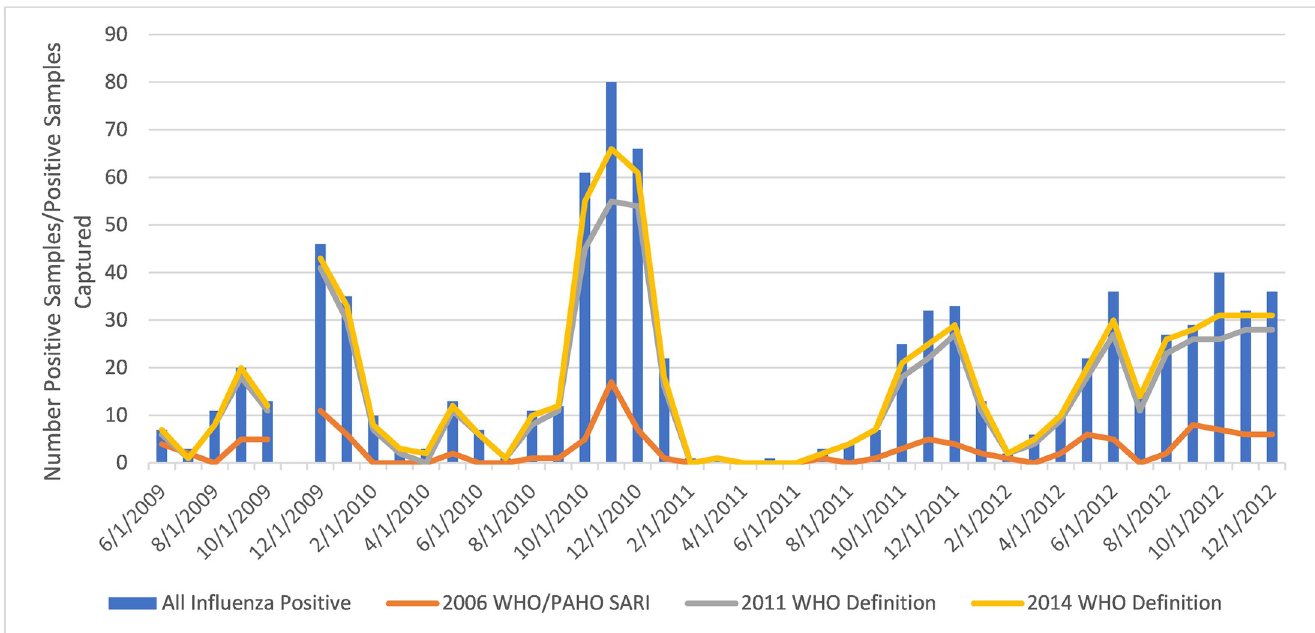
Fig 1. Comparison of influenza epidemiological curves for June 2009-December 2012 using the 2006 PAHO/WHO SARI, 2011 and 2014 WHO SARI case definitions.